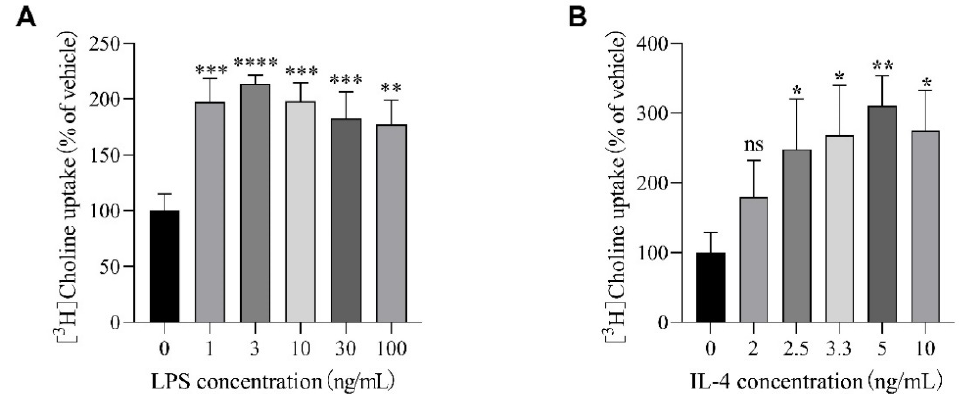
Figure 3. Effects of LPS and IL-4 on [ 3 H]choline uptake in SIM-A9 cells. Cells were preincubated with various concentrations of LPS ( A ) or IL-4 ( B ) for 5 h, and the uptake of 10 µ M [ 3 H]choline was then measured for 20 min. Results are shown as the percentage of the control uptake, measured in the presence of vehicle. Each column represents the mean ± S.D. ( n = 4). * p < 0.05, ** p < 0.01, *** p < 0.001, and **** p < 0.0001 compared with vehicle. Data were analyzed with the Dunnett’s multiple comparisons test. ns: no significant difference.